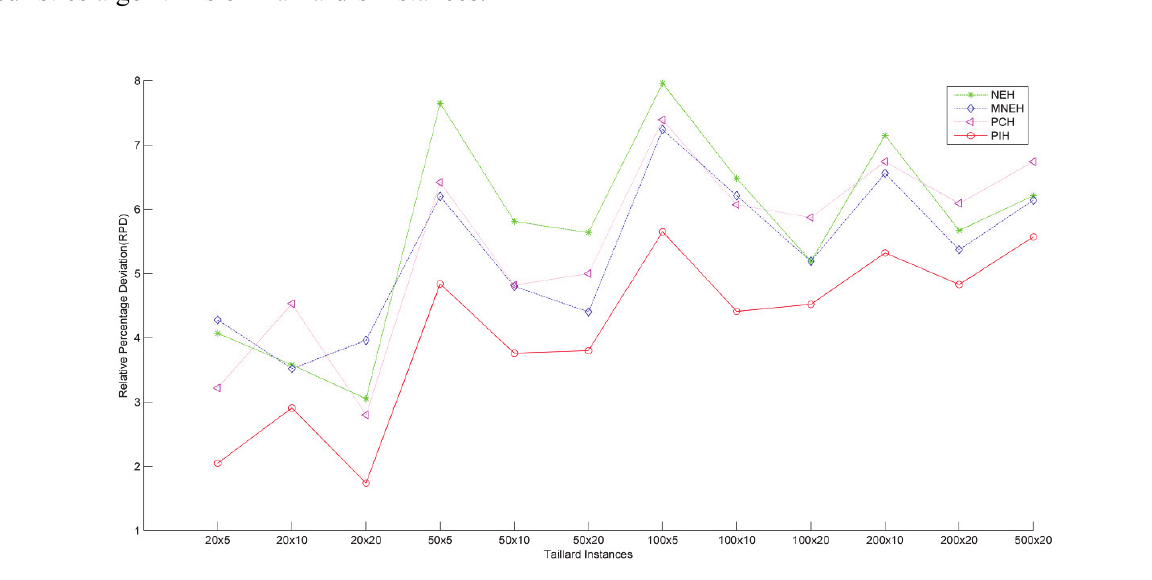
Fig. 1. Plot of RPDs of Heuristics on Taillard Problem